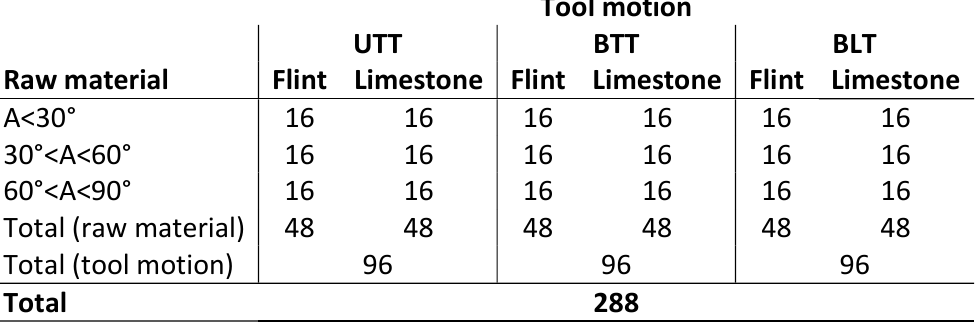
Table 1. Summary of the experimental pieces and action of the first stage of the experiment.